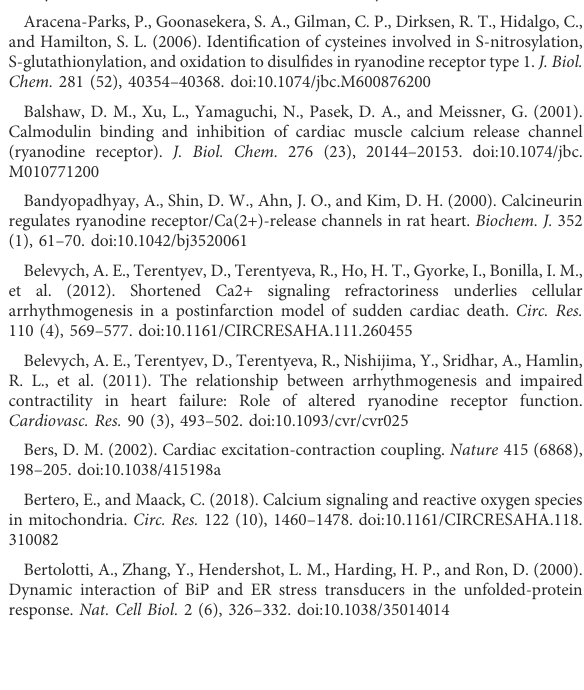
arrhythmias and sudden cardiac death, uncovering novel axes of intraluminal interactions between SR/ER stress proteins and SR Ca 2+ handling proteins, whether direct or indirect through redox modi fi cation, may reveal new therapeutic approaches for Ca 2+ -dependent